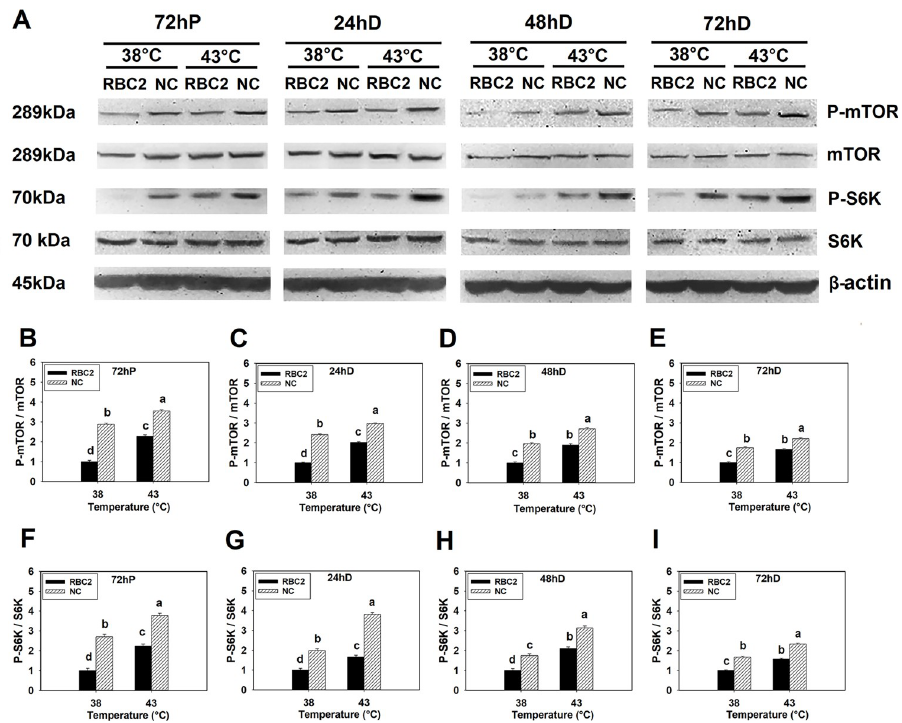
Fig 1. Effect of heat stress on the phosphorylation of mTOR and S6K in RBC2 and NC line SCs. (A) Protein levels of the unphosphorylated and phosphorylated forms of mTOR and S6K, and an internal control β -actin in SCs from the RBC2 and NC lines cultured at 38˚ or 43˚C determined by western blot analysis at 72 h of proliferation (72hP) and 24 h (24hD), 48 (48hD), and 72 h (72hD) of differentiation. Molecular weight and name of each target protein is shown on the left and right side of each figure, respectively. The densitometric ratio of phosphorylated to unphosphorylated mTOR was analyzed in each treatment group at 72hP (B), 24hD (C), 48hD (D), and 72hD (E). The densitometric ratio of phosphorylated to unphosphorylated S6K was analyzed in each treatment group at 72hP (F), 24hD (G), 48hD (H), and 72hD (I). Each graph bar represents a mean ratio, and each error bar represents a standard error of the mean value. Mean values without the same letter are significantly different ( P �